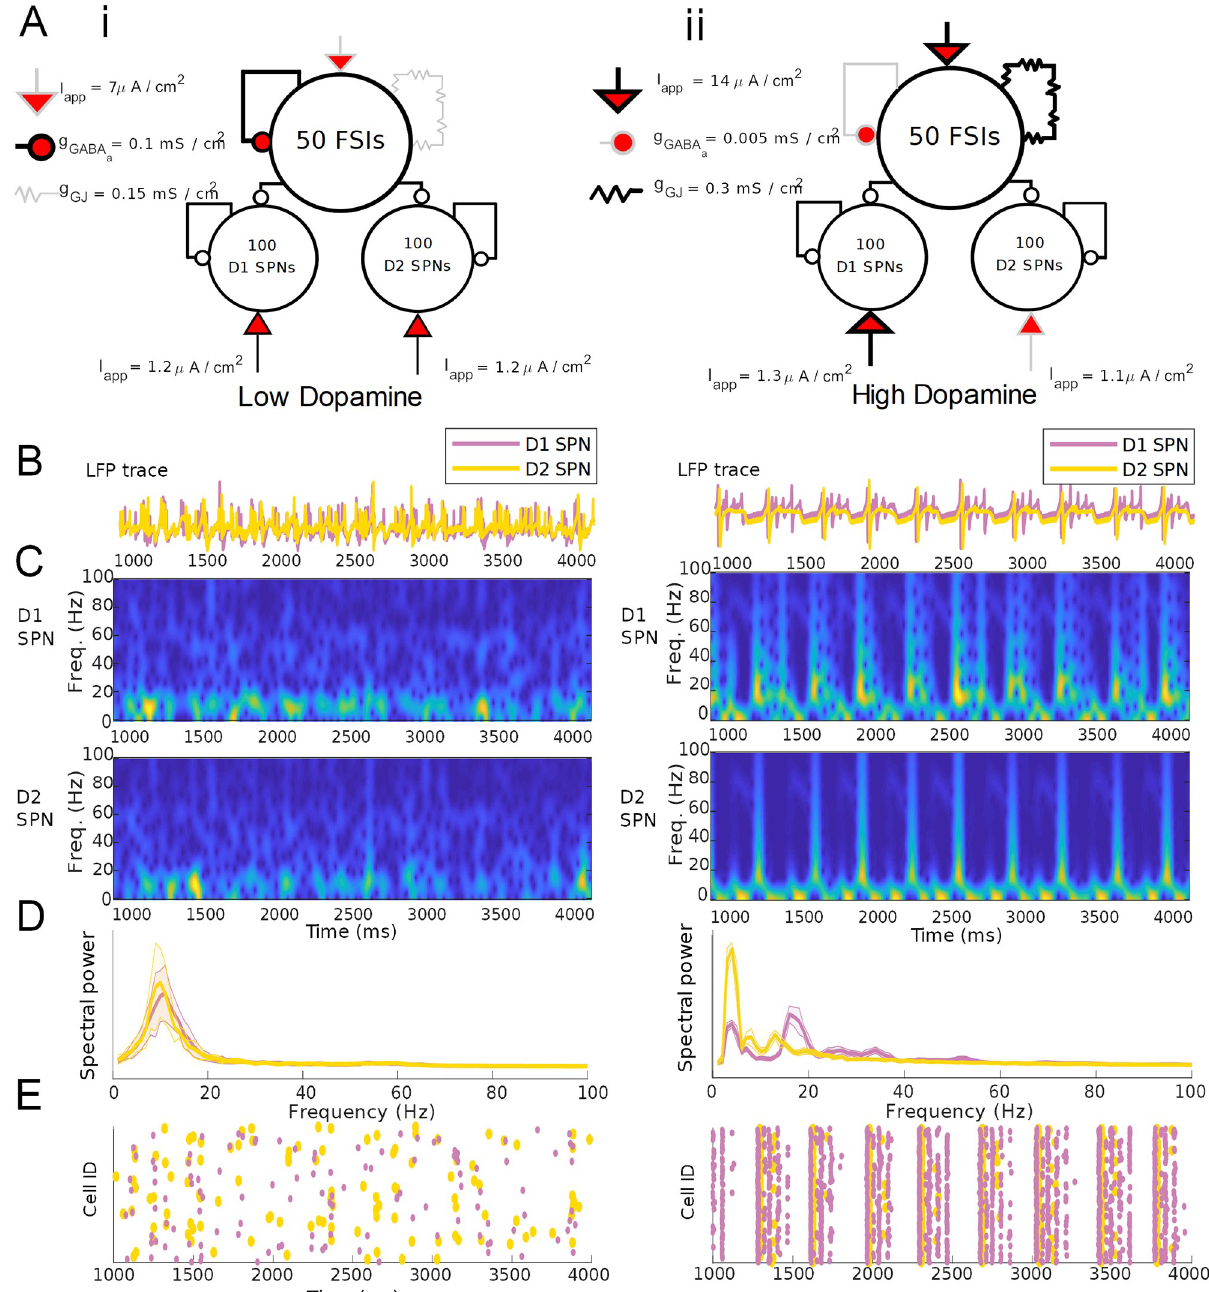
Fig 6. FSIs paradoxically excite and pattern SPN network activity. (A) Schematics showing modulation during the baseline (i) and high (ii) DAergic tone conditions in a combined FSI-SPN network. (B) Mean voltages for the D1 and D2 SPN populations in the two conditions. (C) Spectrograms of mean voltage for the D1 subpopulation (upper) and D2 subpopulation (lower). (D) Power spectral density of D1 and D2 population activity, averaged over 20 simulations. Shading represents standard deviation from the mean. Power spectra are derived using Thomson’s multitaper power spectral density (PSD) estimate (MATLAB function pmtm). (E) Raster plots of SPN population activity.